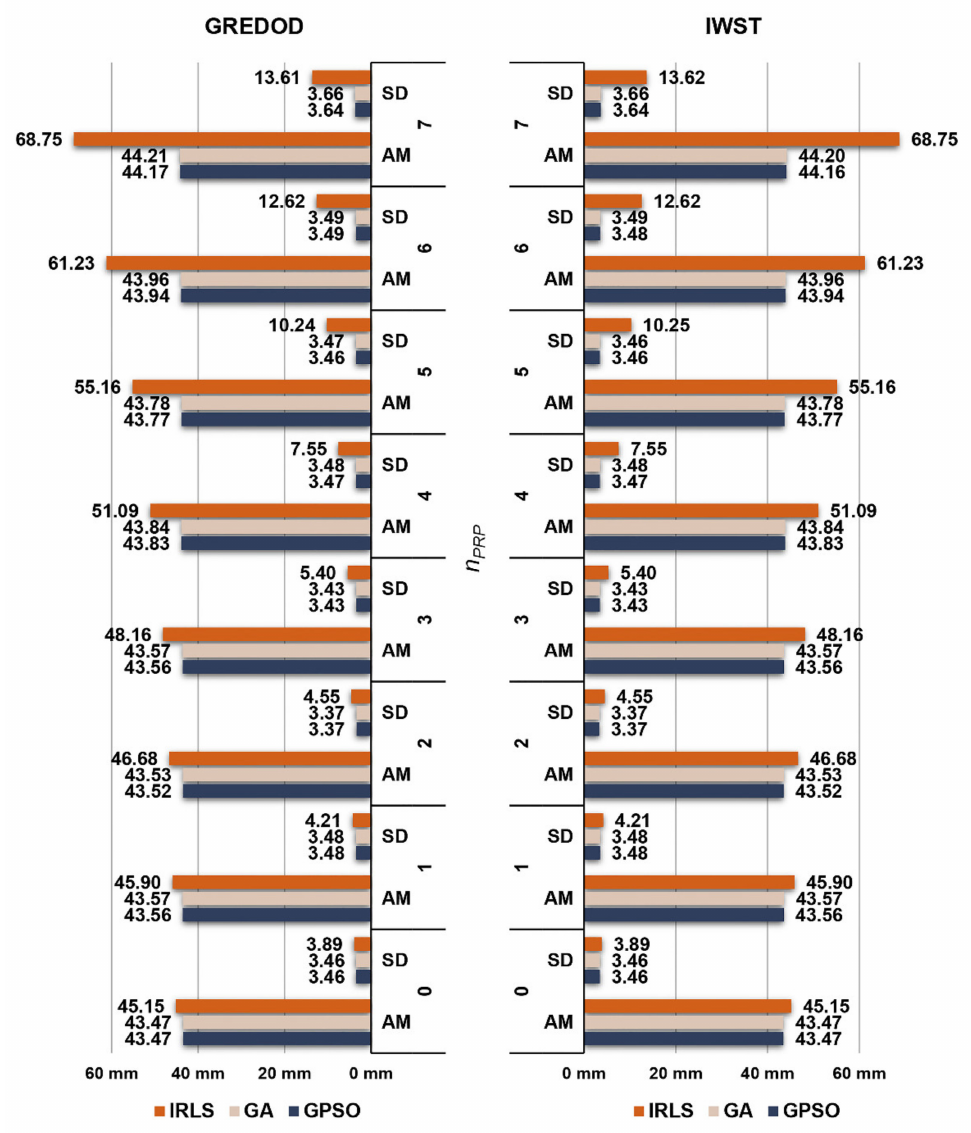
Figure 8. Arithmetic mean (AM) values and standard deviations (SDs) of overall absolute true errors e ˆ of the GREDOD and IWST methods for variant d